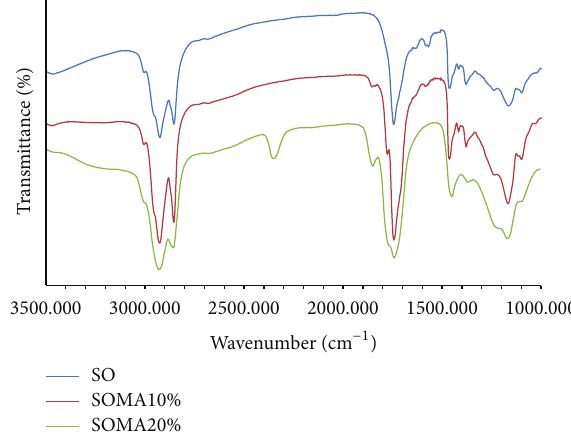
Figure 1: FTIR spectra of soybean oil and soybean oil